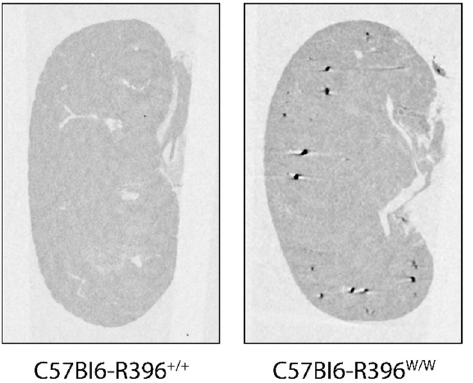
Figure 3. Nephrolithiasis in C57Bl6-R396 w/w mutant pups. Kidneys were harvested at P7 and imaged by microCT.